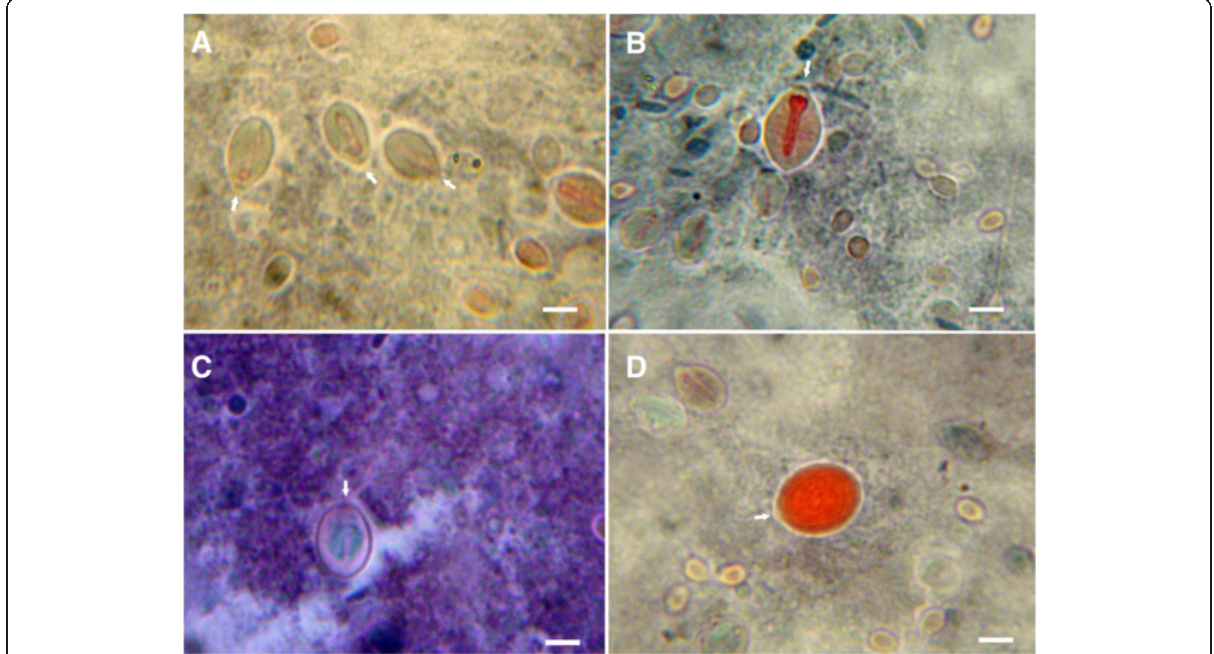
Fig. 4 Nematocytes of C. tagi viewed with Masson ’ s trichrome staining using optical microscopy. Arrows highlight operculum. Collagenous materials in green or blue. Red colour is attributed to cationic proteins. a and b Euryteles; shaft stained in red and around it a green material filling the capsule. c Undefined nematocyst with a green material filling the core. d Birhopaloid, all stained in red due to its tubule which fulfills the inner capsule. Bars: ( a and b ) 5 μ m; ( c and d ) 4 μ m